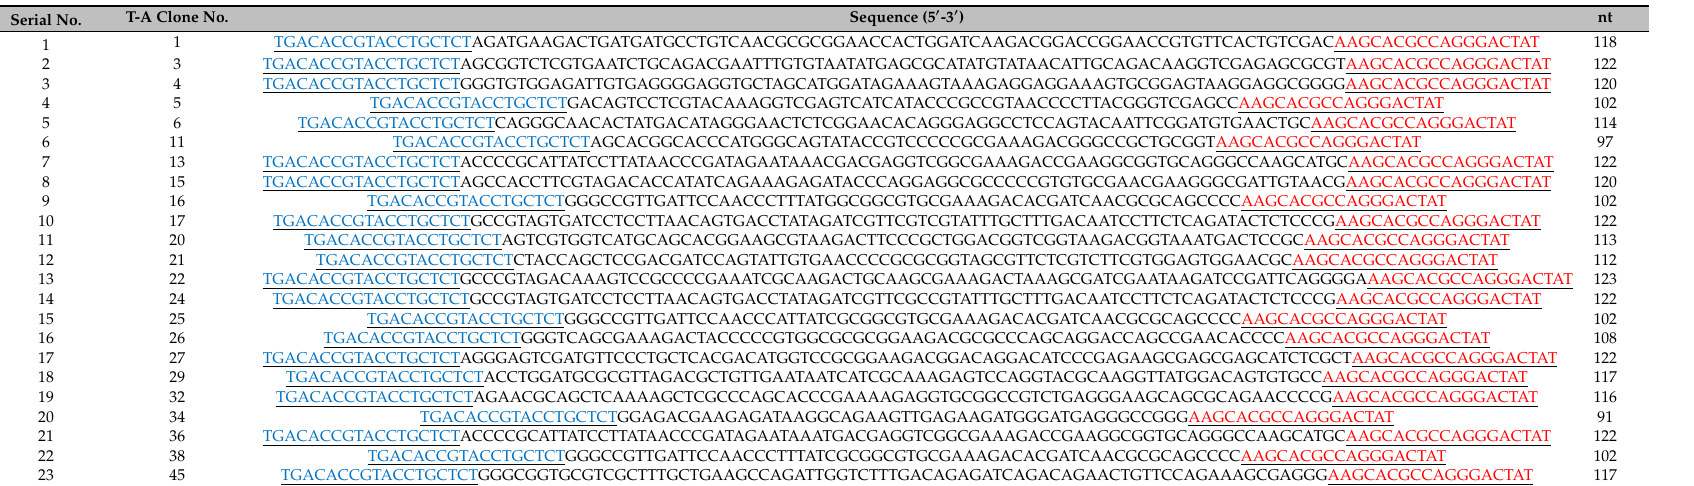
Table 2. The selection of 23 non-redundant dsDNA sequences (as templates for putative aptamers against the RBSDV His-P10 protein) from 50 T-A cloning constructs at SELEX round